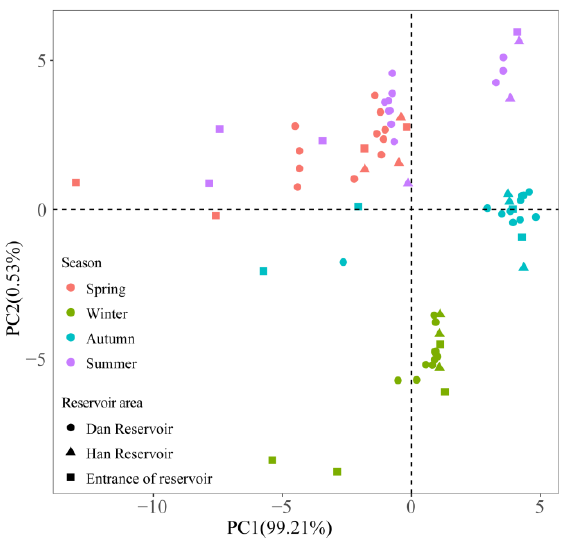
Figure 3. PCA of environmental factors of the Danjiangkou Reservoir in different seasons and dif- ferent reservoir areas.